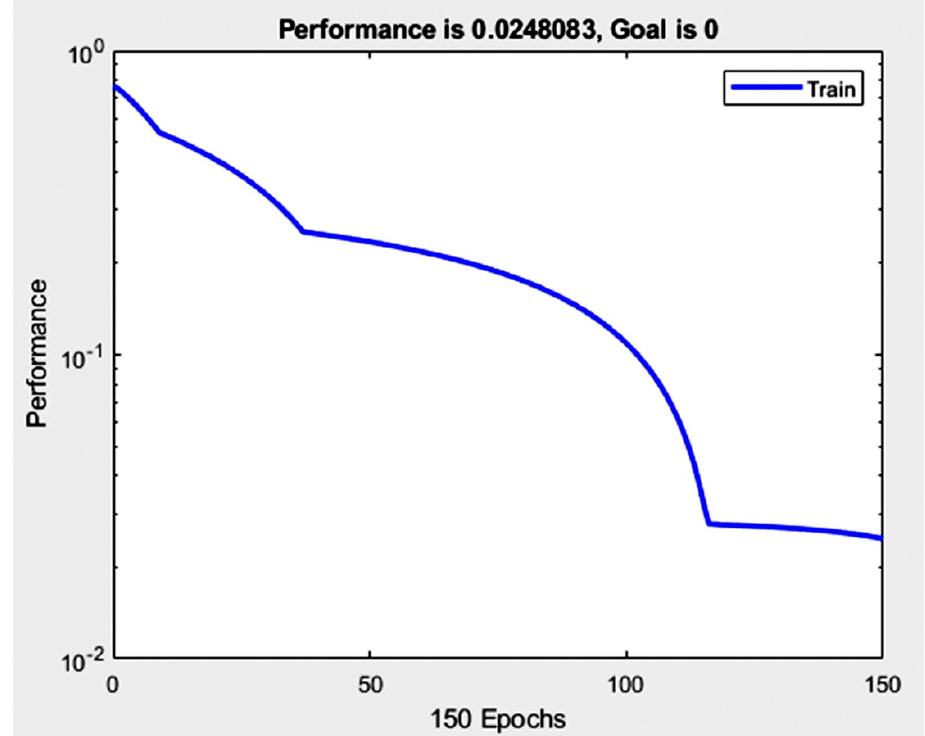
Figure 8. Performance of training for Duval_Triangle_4_RBFNN.